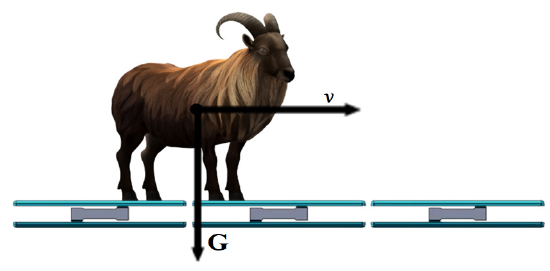
Figure 4. Weigh system architecture.